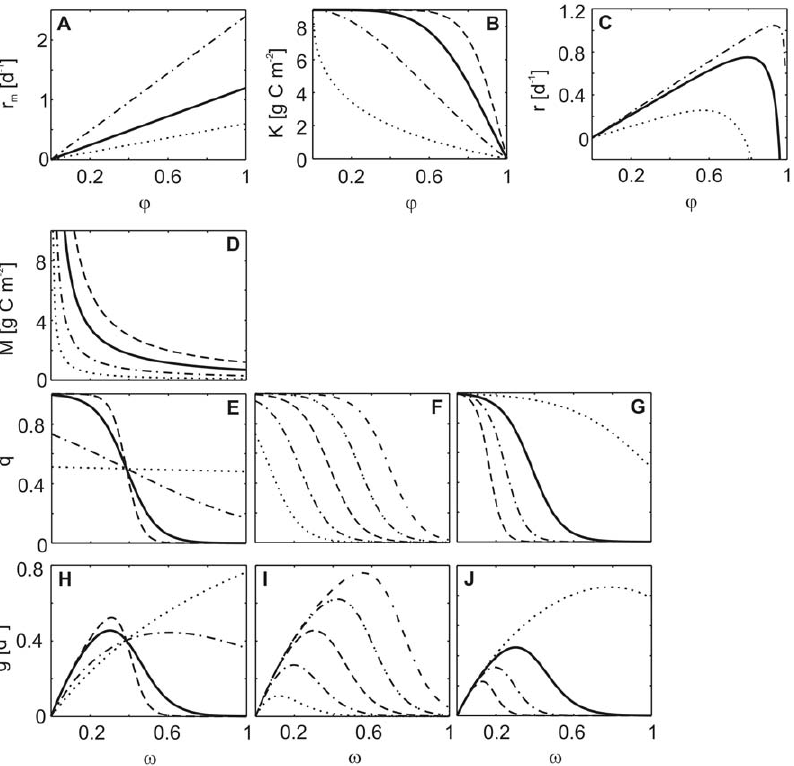
Figure 4. Trade-off functions between trait values of the prey (A–C) and the predator (D–J). Thick solid lines represent the functions used in the standard run. ( A ) Maximum prey growth rate r m , Eq. (14), for r m 0 =1.2 (solid), 0.6 (dotted), 2.4 (dot-dashed), ( B ) carrying capacity K , Eq. (15), for a =5 (solid), 0.5 (dotted), 2 (dot-dashed), 10 (dashed), and ( C ) gross growth rate, Eq. (7), for prey biomasses=0.1 (solid), 1 (dotted), 5 (dot-dashed) in dependence of edibility Q . ( D ) Half-saturation constant M , Eq. (17), for M 0 =0.7 (solid), 0.1 (dotted), 0.3 (dot-dashed), 1.2 (dashed), ( E ) food-suitability q , Eq. (16), for b =10 (solid), 0.1 (dotted), 2 (dot-dashed), 20 (dashed), and ( F ) q for Q =0.1 (dotted), 0.3 (dot-dashed), 0.5 (dashed), 0.7 (double-dot- dashed), 0.9 (dot-triple-dashed) in dependence of food-selectivity v , ( G ) q for c =1.3 (solid), 0.5 (dotted), 2 (dot-dashed), 3 (dashed), ( H ) grazing rate g , Eq. (8), for four different values of b (see E ) and Q ~ 0 : 5 , X ~ 1 g C m { 2 , ( I ) grazing rate g for 5 different values of Q (see F ) and b ~ 10 , X ~ 1 g C m { 2 and ( J ) q for four different values of c (see G ) in dependence of v . Constants as in Table 1. For details an equations see section ‘‘‘Trade-offs’’’ in Methods.